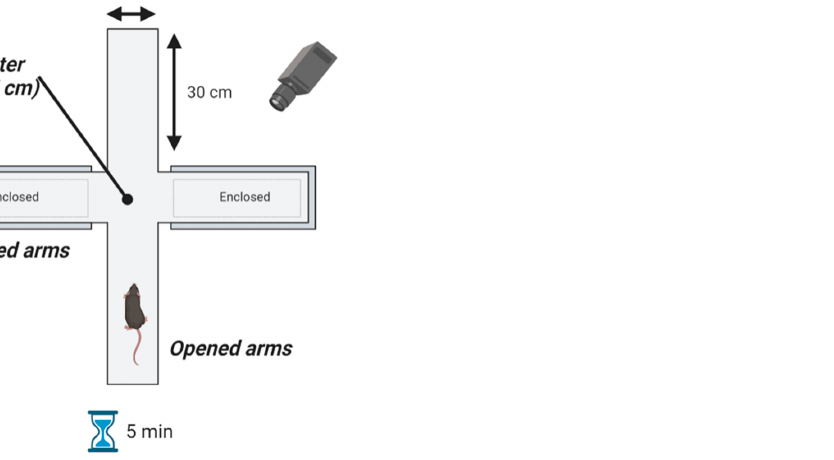
Figure 5. Characteristics of the Elevated Plus Maze. The maze consists of four arms: two non-consecutive open arms (30 cm long × 5 cm wide) and two closed arms that generate a common center zone (5 × 5 cm). The EPM was placed 60 cm above the floor. To start the test, each mouse was placed in one of the opened arms facing the opposite direction of the center and was free to move for 5 min. All sessions were recorded using a camera located over the maze. Figure created by BioRender.com.